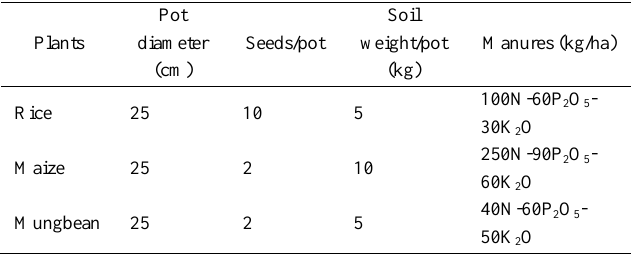
Table 2. Physical-chemical properties of water and soil of the initial